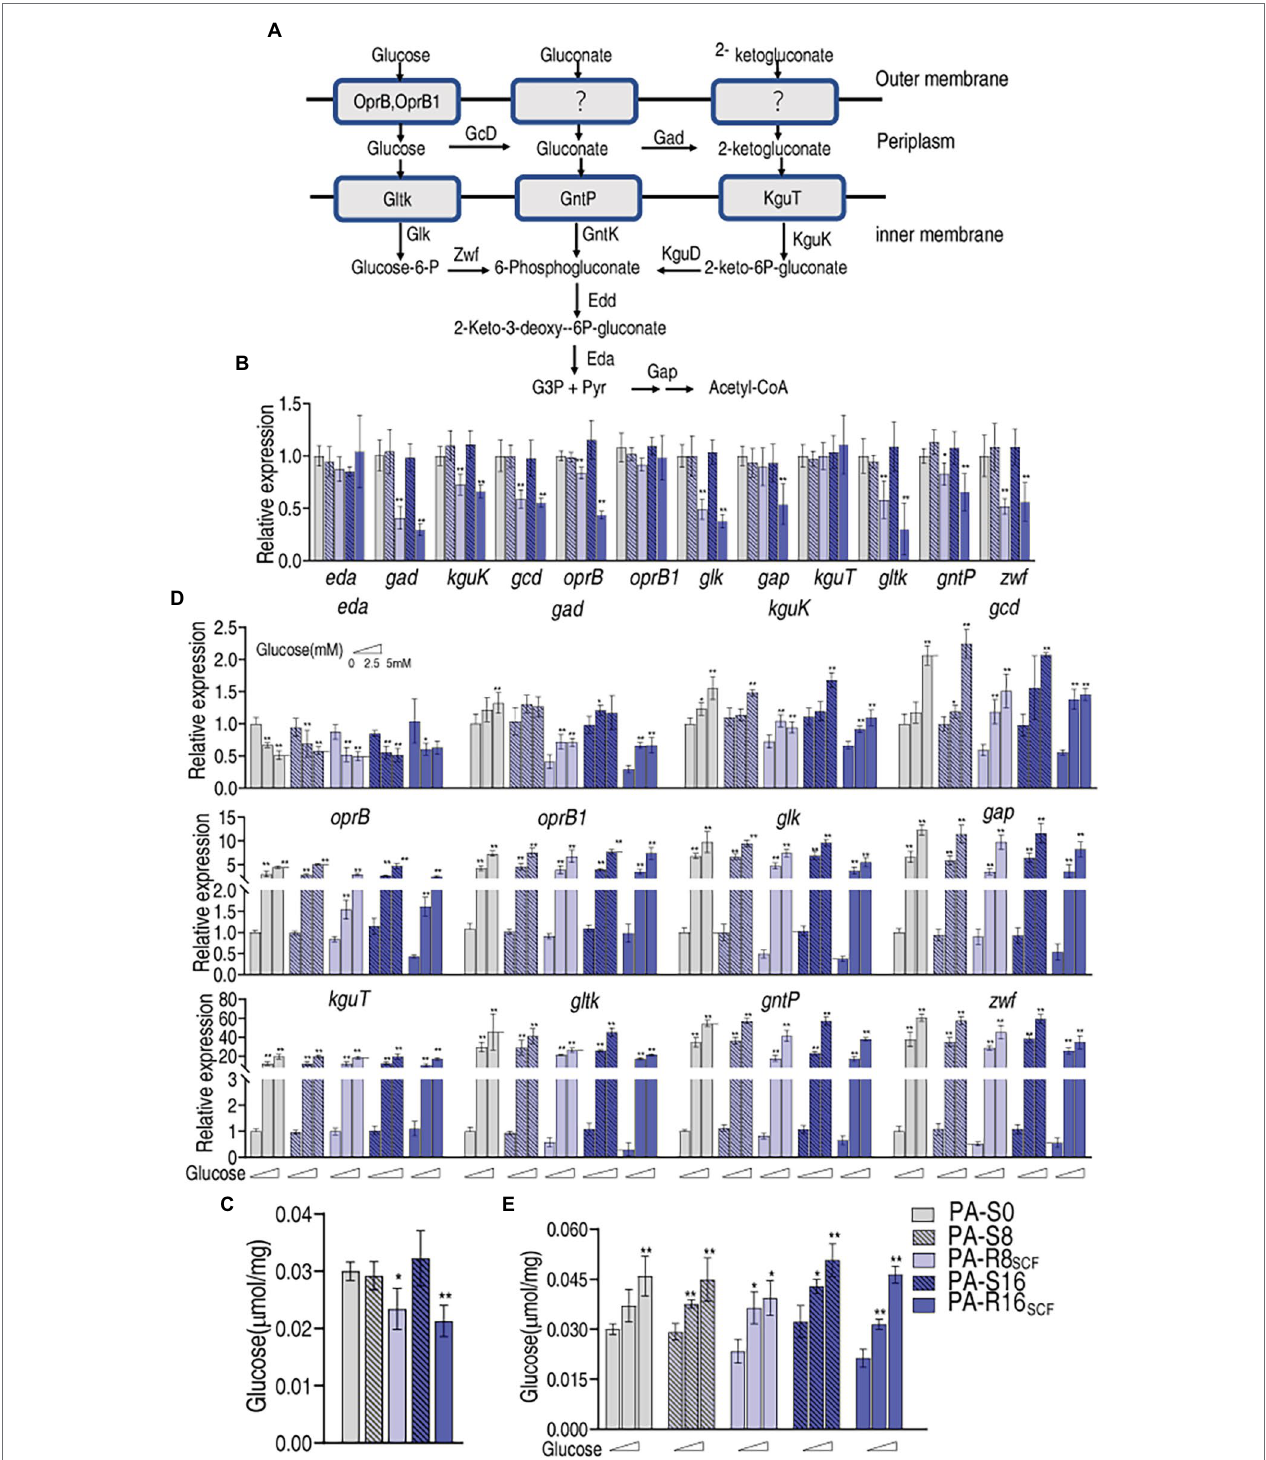
FIGURE 5 | Glucose transport with and without exogenous glucose in PA-R8 SCF and PA-R16 SCF . (A) Metabolic diagram of glucose transport (Daddaoua et al., 2017). (B) Quantitative real-time PCR (qRT-PCR) for expression of genes encoding glucose transport proteins between PA-R8 SCF , PA-R16 SCF , and PA-S8, PA-S16, respectively. (C) Glucose level in data (B) . (D) qRT-PCR for expression of genes encoding glucose transport proteins between PA-R8 SCF , PA-R16 SCF , and PA-S8, PA-S16, respectively, in the presence of different concentrations of glucose. (E) Glucose level in data (D) . Results are displayed as mean ± SEM and at least three biological repeats are performed. Significant differences are identified * p < 0.05, ** p <